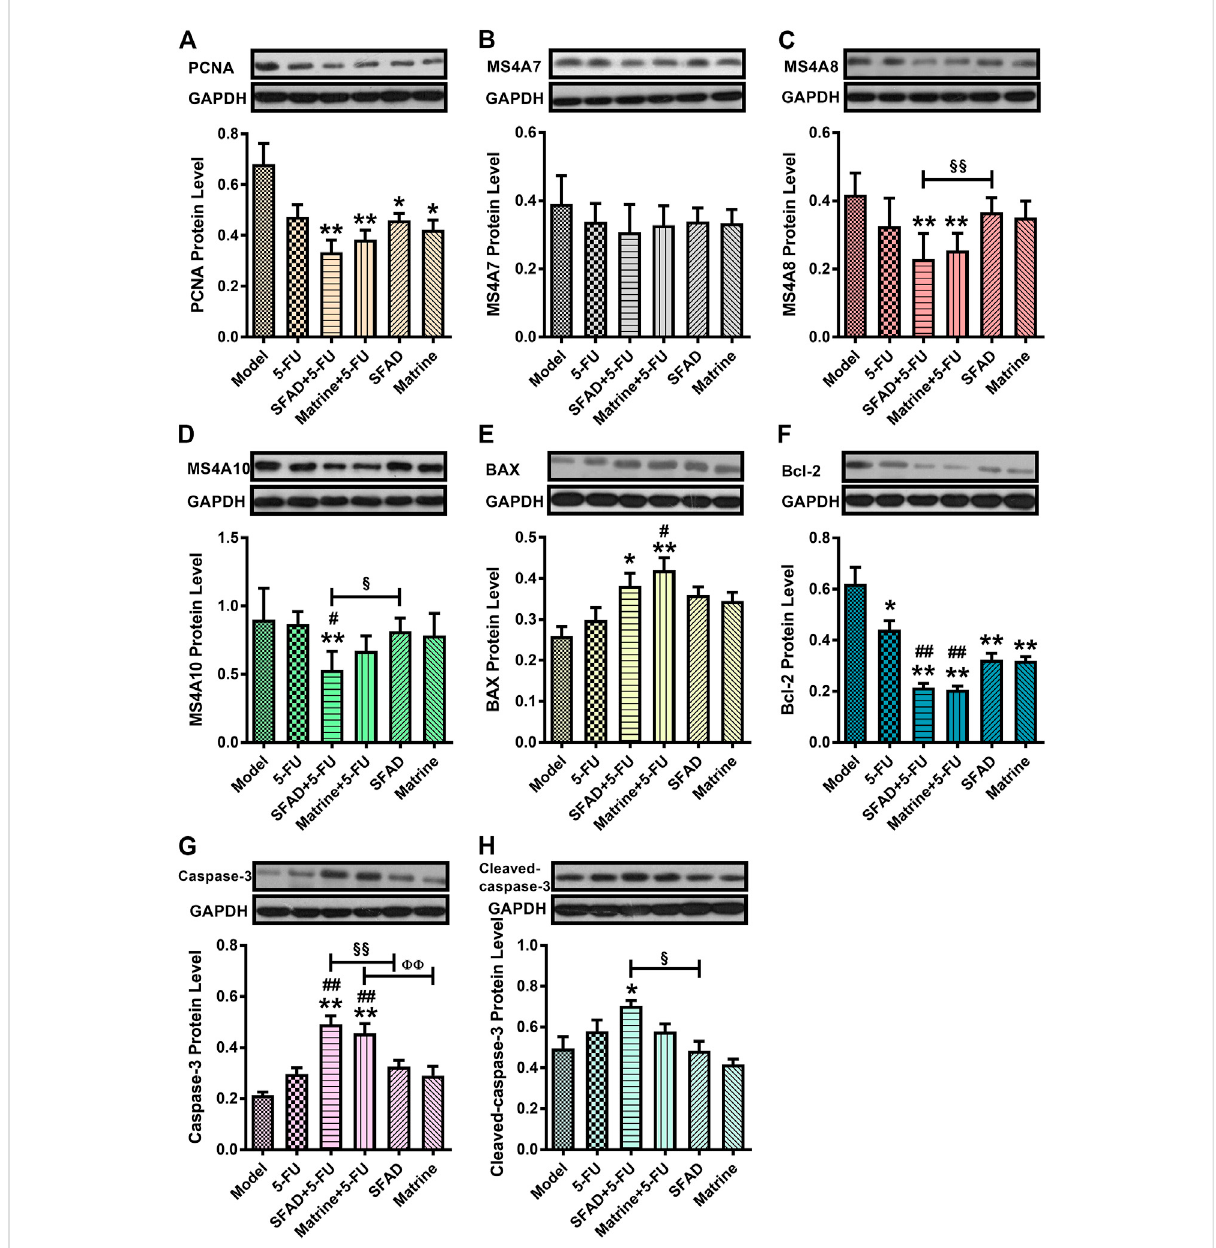
FIGURE 8 Effects of SFA/matrine+5-FU onserum protein expression of PCNA, MS4A7, MS4A8, MS4A10, Bax, Bcl-2, Caspase-3, and cleaved Caspase-8 in tumor tissues of BGC-823-transplanted nude mice. (A) Relative PCNA levels. (B) Relative MS4A7 levels. (C) Relative MS4A8 levels. (D) Relative MS4A10 levels. (E) Relative BAX levels. (F) Relative Bcl-2 levels. (G) Relative Caspase-3 levels. (H) Relative cleaved Caspase-3 levels. Data are presented as themean ±SD ofsix nudemice per group. * p < 0.05, ** p < 0.01 vs.themodelgroup; # p < 0.05, ## p < 0.01 vs. the5-FU group; § p